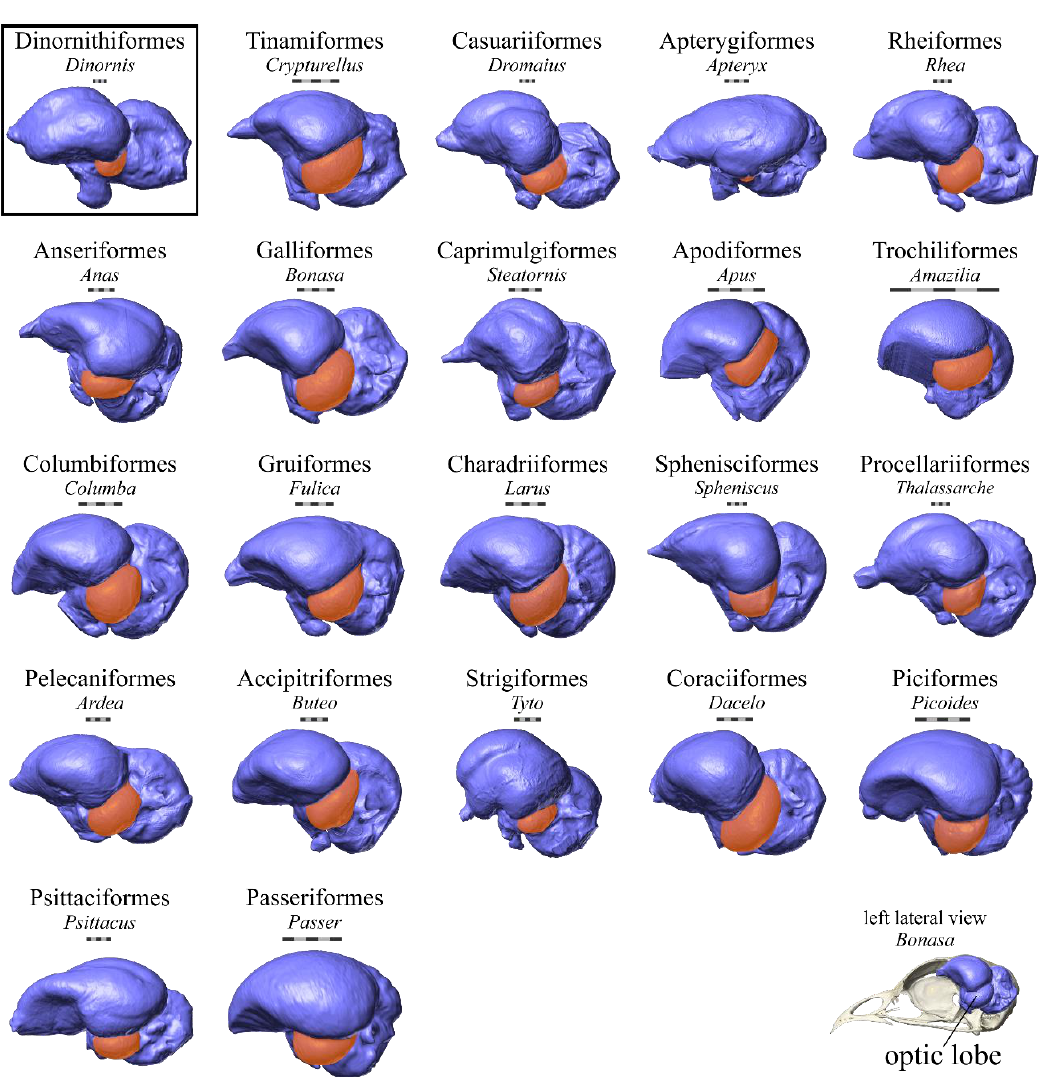
Figure 6. The endocast of Dinornis robustus and a representative sample of endocasts of the extant orders of birds analyzed in this study in left lateral view (see skull and endocast of Bonasa umbellus at bottom right for orientation). Optic lobes are highlighted in orange to aid in comparison of relative size of this structure across taxa. Scale bars = 5 mm.